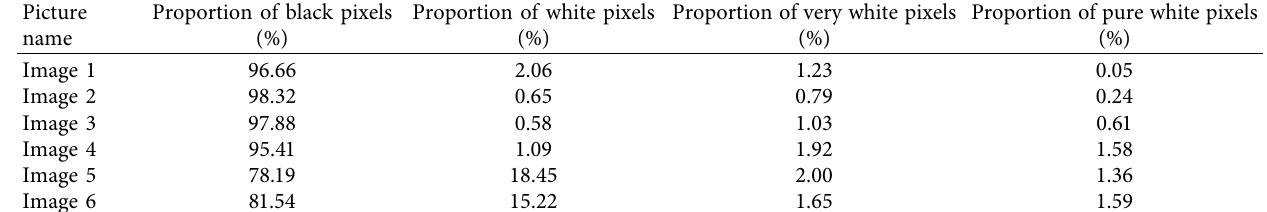
Table 8: Disease ratio statistics.